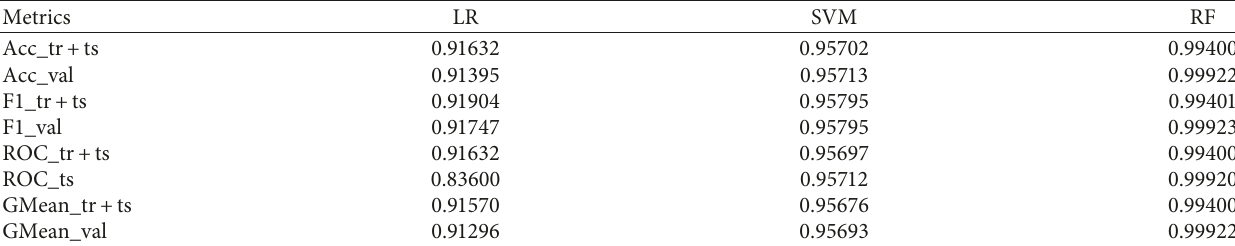
Table 12: For retweeting interactions from May 21 until May 26 in 2021, utilizing the similarities between nodes, performance of the LR, SVM, and RF models 1 .